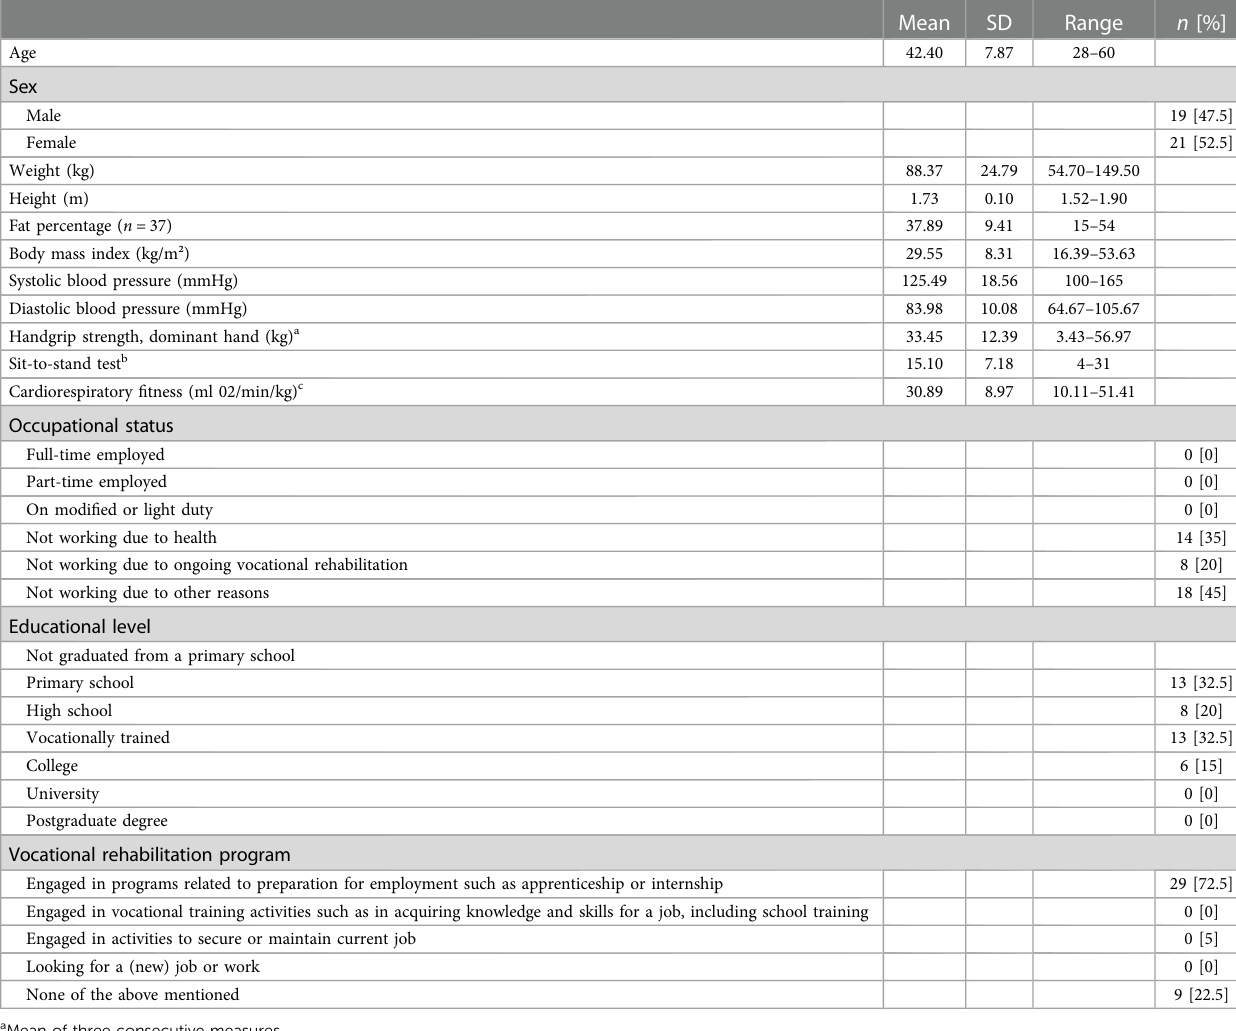
TABLE 1 Characteristics of the sample, n